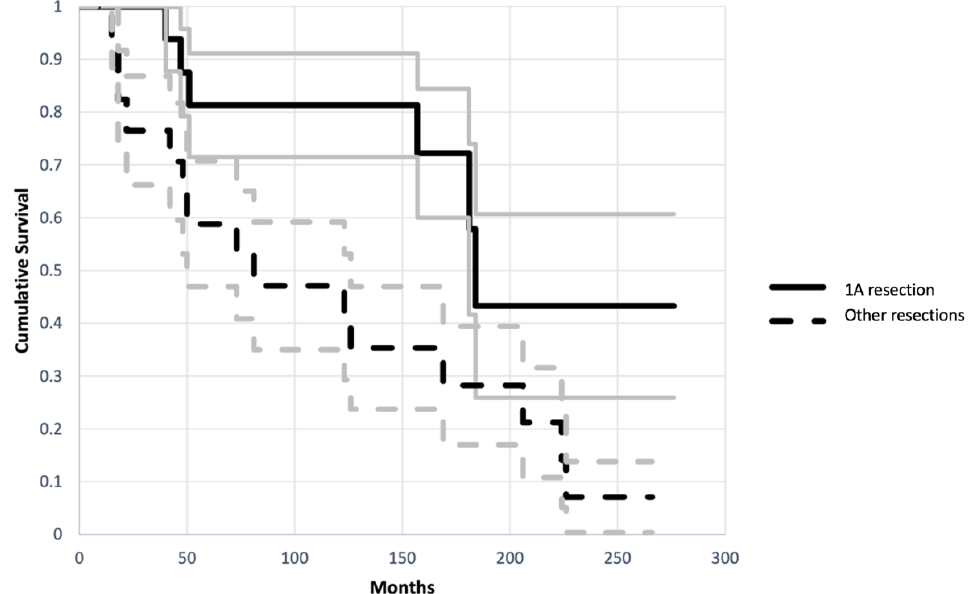
Figure 3. Kaplan-Meier plot shows different cumulative survival in Group 1 (A1 resection) and in Group 2 (Other resections) (CI 95%, p = 0.02). Endpoint of analysis was at least one surgical operation for revision of implant due to mechanical failure (aseptic loosening, fracture or resorption of the allograft, dislocation or breakage of the hardware). Grey lines represent standard deviation.